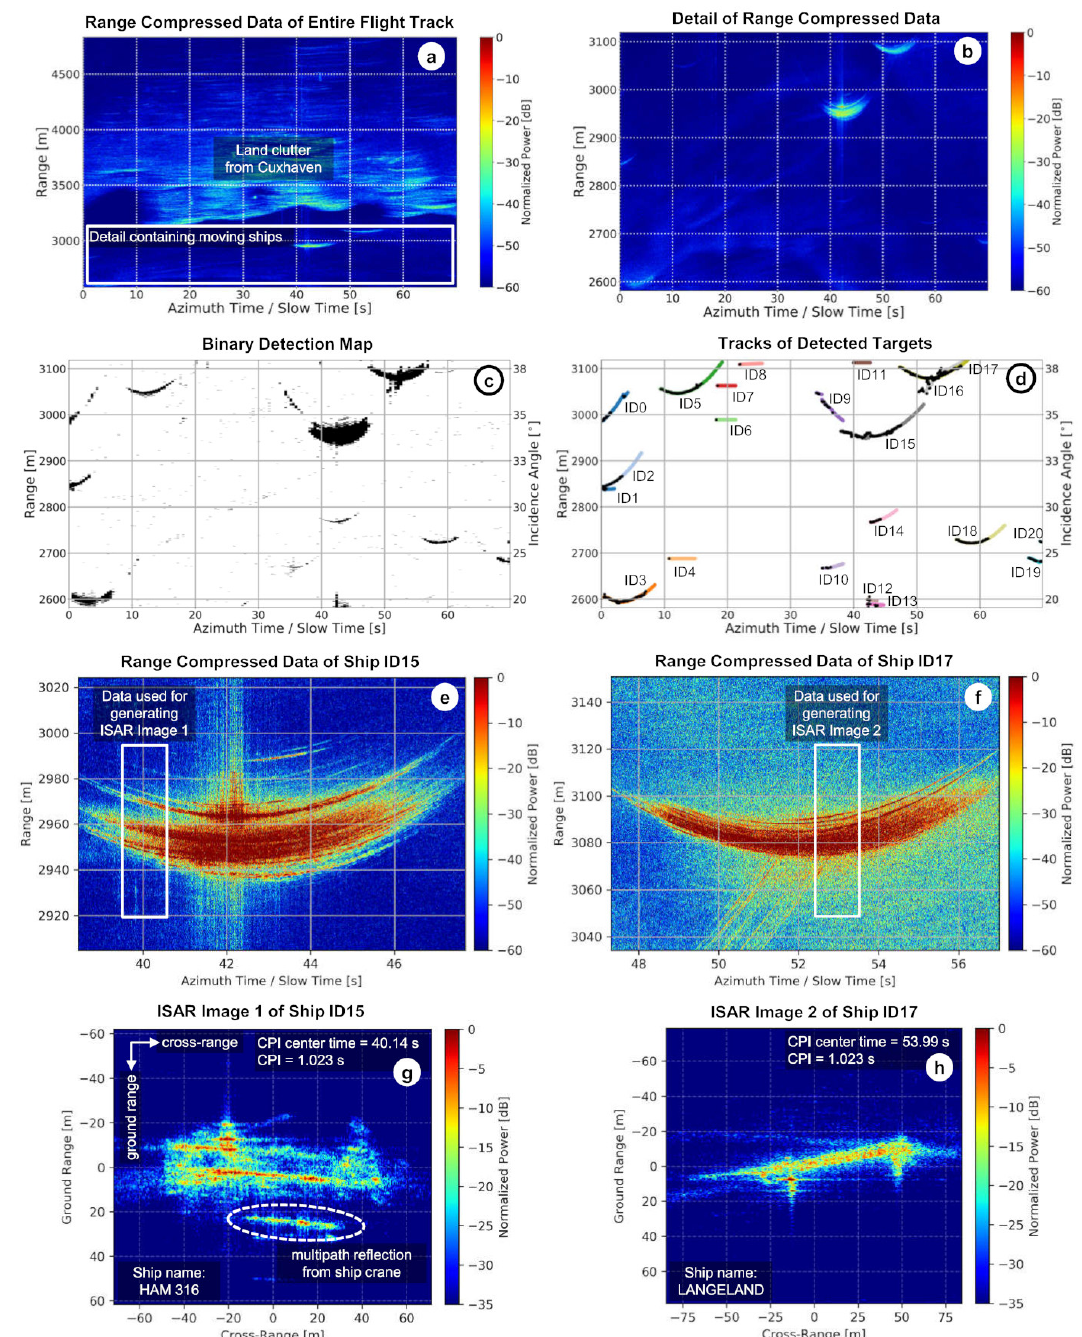
Figure 13. Preliminary ship detection, tracking and ISAR imaging result obtained from V-SAR airborne radar data. In the images, the following are shown: ( a ) range-compressed radar data acquired during a single linear flight track (the corresponding fully focused SAR image is shown in Figure 8 at the top); ( b ) crop of the data containing several ship signals but no land clutter; ( c ) binary detection map obtained after applying a CFAR detector; ( d ) ship tracking results obtained by a tracker based on the Kalman filter; ( e , f ) range-compressed data belonging to the tracked ships with IDs 15 and 17; and ( g , h ) corresponding ISAR images obtained by a generic ISAR processor—the used CPI of 1.023 s results in a cross-range resolution of approximately 0.6